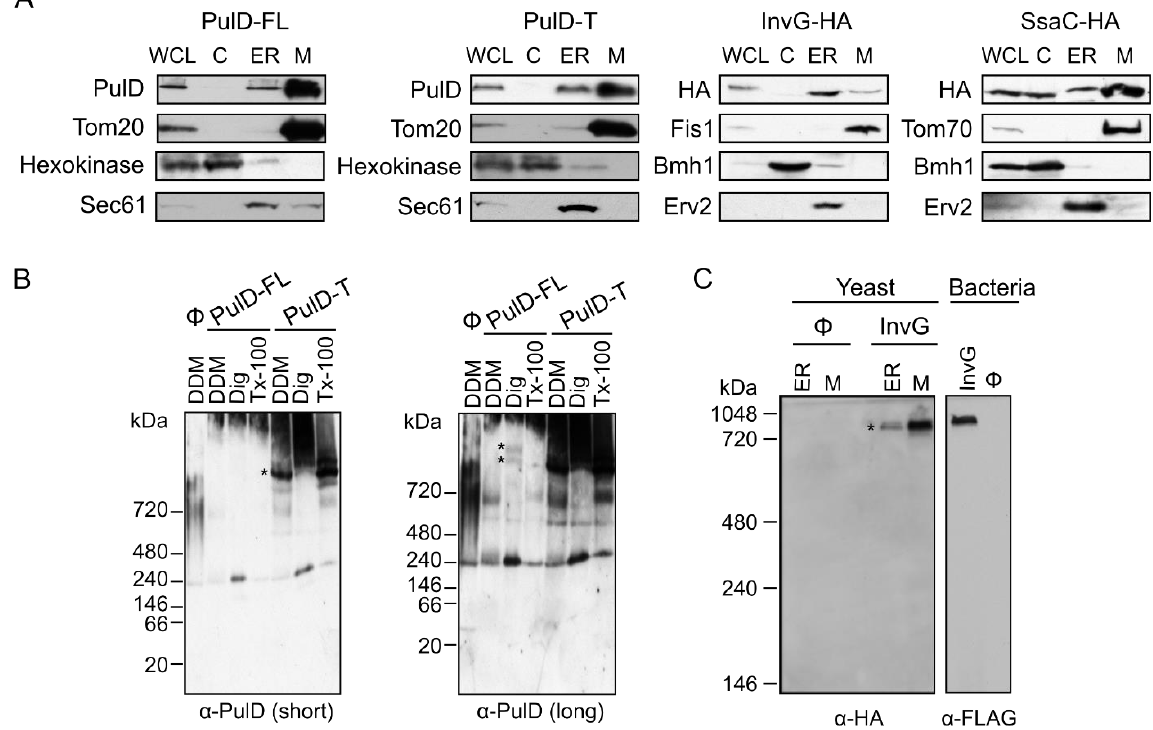
FIGURE 2: Bacterial secretins are targeted within yeast cells mainly to mitochondria and form native-like complexes. (A) Whole cell lysate (WCL) and fractions corresponding to cytosol (C), light microsomes (ER) and mitochondria (M) were obtained from wild type yeast cells transformed with a plasmid encoding the indicated secretin. Samples were analysed by SDS – PAGE and immunodecoration with antibodies against PulD, HA tag, and the marker proteins Tom20, Tom70 or Fis1 for the mitochondrial fraction, Bmh1 or Hexokinase for the cytosol, and Erv2 or Sec61 for the microsomal/ER fraction. (B) Mitochondria were isolated from wild type yeast cells transformed with the indicated PulD variant. The isolated organelles were solubilized with 1% digitonin, 1% DDM, or 0.5% Triton X-100 and analysed on a 6-13% BN-PAGE followed by immunodecoration with antibodies against PulD. Short and long exposures are presented. High molecular weight oligomers are indicated by asterisks. (C) Microsomal (ER) or mitochondria (M) fraction isolated from wild type cells transformed with an empty plasmid (Ø) or a plasmid encoding HA-tagged InvG were lysed with 1% DDM and further analysed as described in part (B). Membranes of bacterial cells transformed with an empty plasmid (Ø) or a plasmid encoding FLAG-tagged InvG were treated and analysed in parallel in the same way. High molecular weight oligomers are indicated by